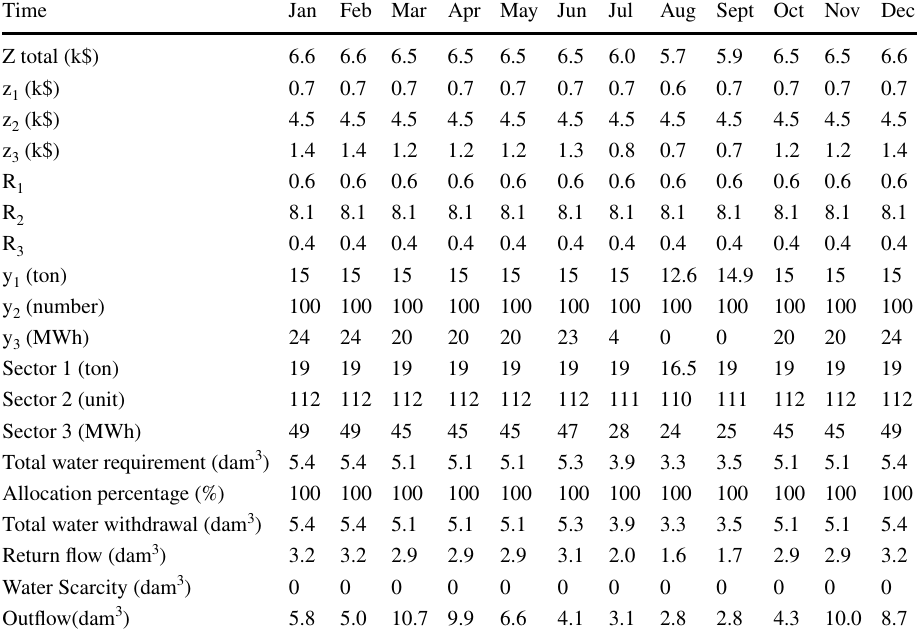
Table 3 The results of the temporal coupled